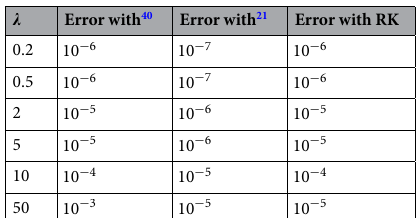
G 0 ) shear stress achieved by means of modified ′ ( − =